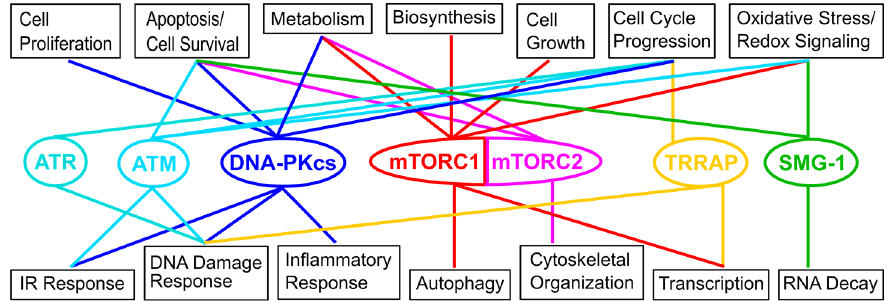
Figure 1. Overview of the six known human PIKKs and their roles in different cellular processes. For the figure information provided in the text and from three reviews has been used [4–6]. IR—ionizing